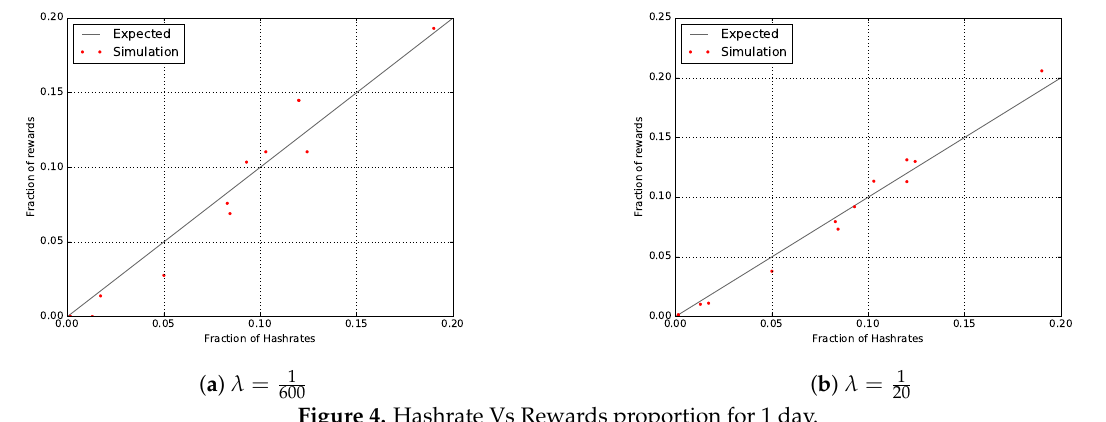
Figure 4. Hashrate Vs Rewards proportion for 1